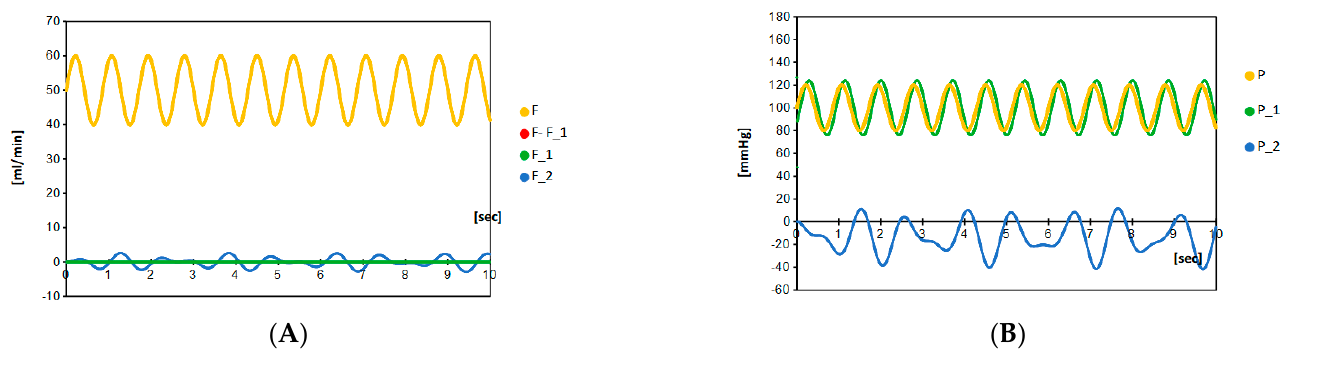
Figure 3. ( A ) The branching of blood flow from F ( t ) to F 1 ( t ) and F 2 ( t ) at a given setting ( R = 2.2, C 1 = 0.100, C 2 = 0.005 and L 1 = 10, L 2 = 20). Here, we take R = 2.2 for the local blood flow in the main vessel F – F 1 not to change too much (less than 10% in all the calculated cases) compared to F . It simulates the typical case of doubly composed aneurysm. Calculation shows that the blood flow in the artery F is almost equal to the blood flow in the parent artery F – F 1 , and therefore the blood flows in the aneurysms are kept to be small. Depending on the choice of four parameters ( C 1 , C 2 , L 1 , and L 2 ), flows F 1 and F 2 can be either positive, zero or negative. ( B ) In the same parameter setting, the local pressures P 1 ( t ) and P 2 ( t ) are calculated, which note that the blood pressure at the parent artery is equal to P ( t ) regardless of the choice of parameter. In this parameter setting, the amplitude of local pressure P 1 ( t ) is almost equal to P ( t ), while another local pressure P 2 ( t ) oscillates with irregular beat and small